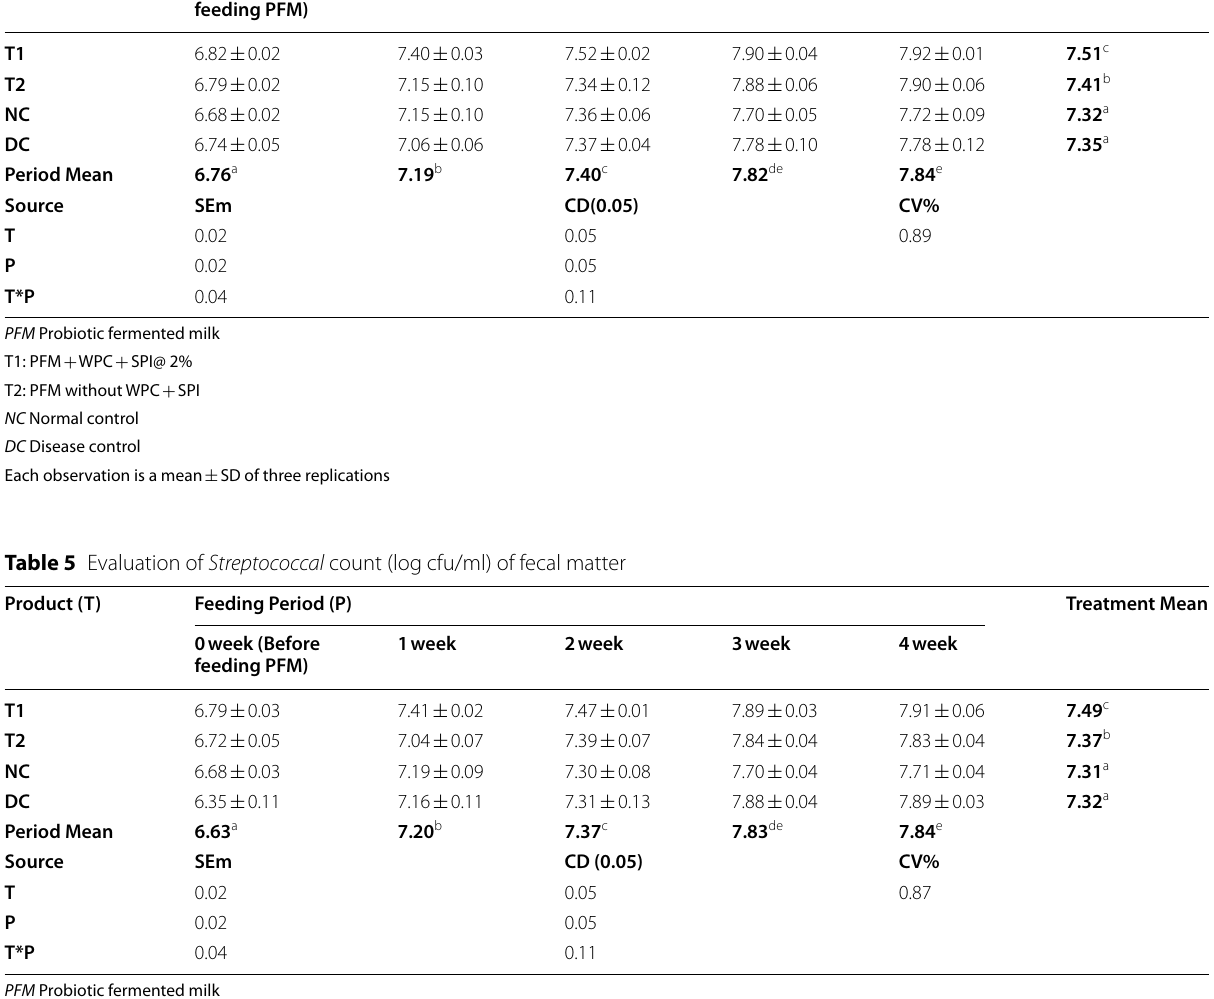
PFM Probiotic fermented